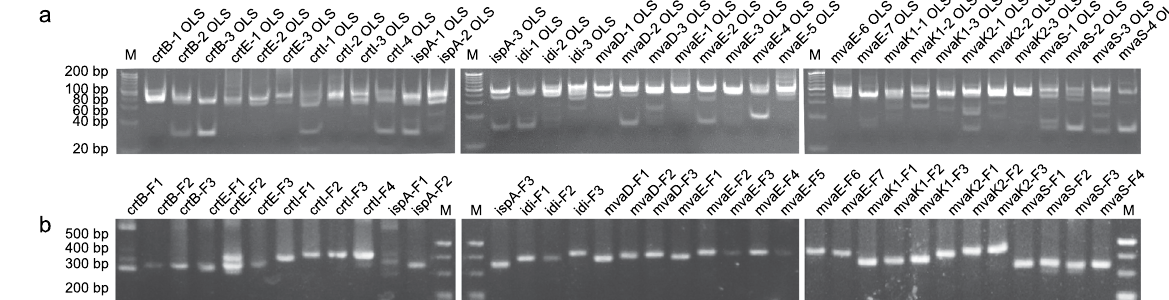
Figure 4. Assembly of fragments using re-amplified subpools from MP-PCR amplicons. ( a ) Amplification of oligo subpools from the MP-PCR amplicons prior to throughput-improved error correction. ( b ) Each fragment was assembled by LCR using re-amplified subpools from MP-PCR amplicons for evaluating the oligo quality of MP-PCR product. M, 20 bp DNA ladder (TaKaRa Bio); OLS, oligo subpool; F, fragment.